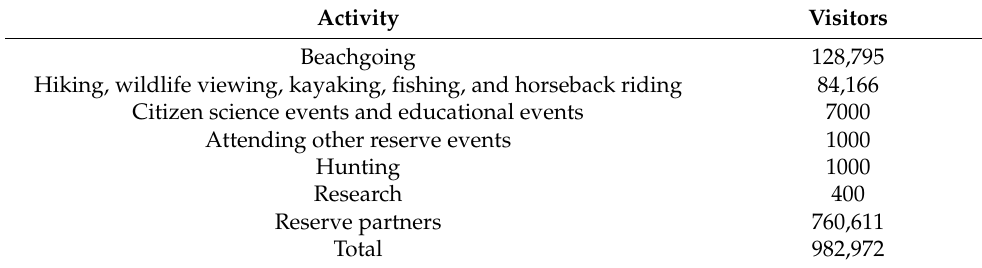
Table 1. Estimated number of annual visitors to the GTM Reserve by activity type.